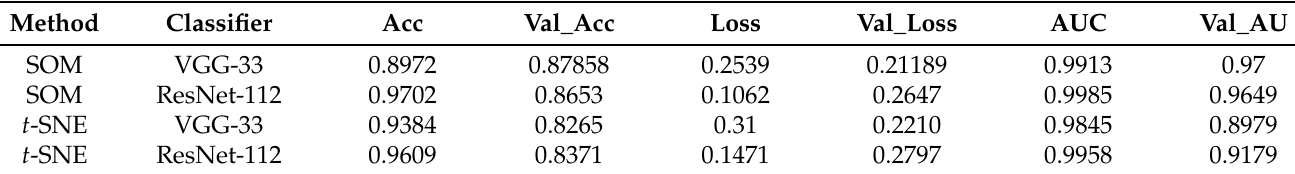
Table 4. Performance comparison among classifiers and embedding methods (merged).